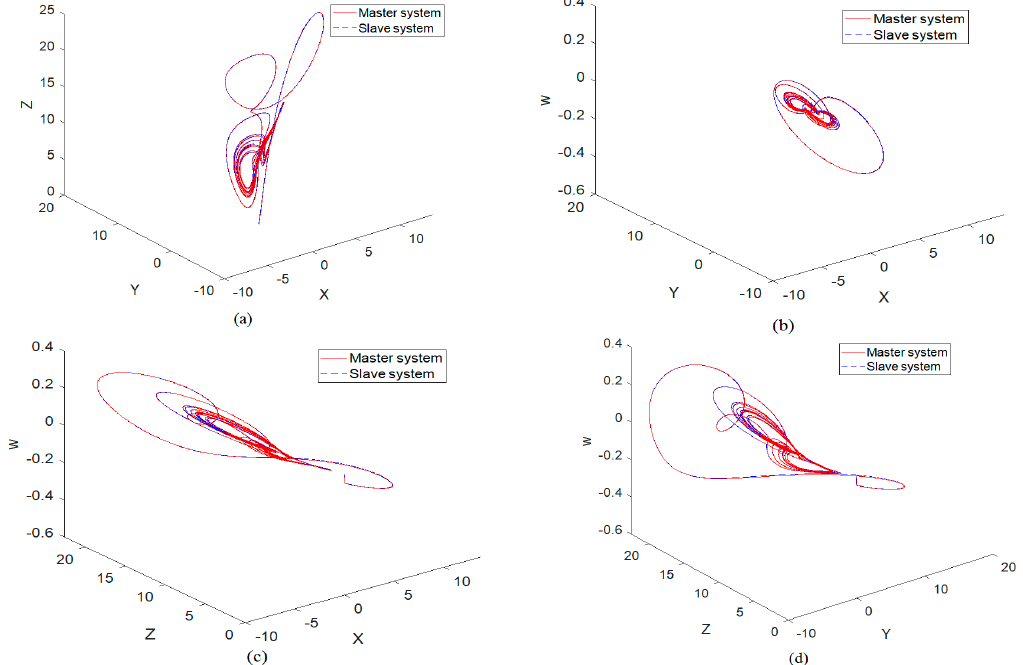
Figure 17. Synchronization of the 4D Lorenz–Stenflo chaotic system using the SRIT2PC for Case 3: ( a )